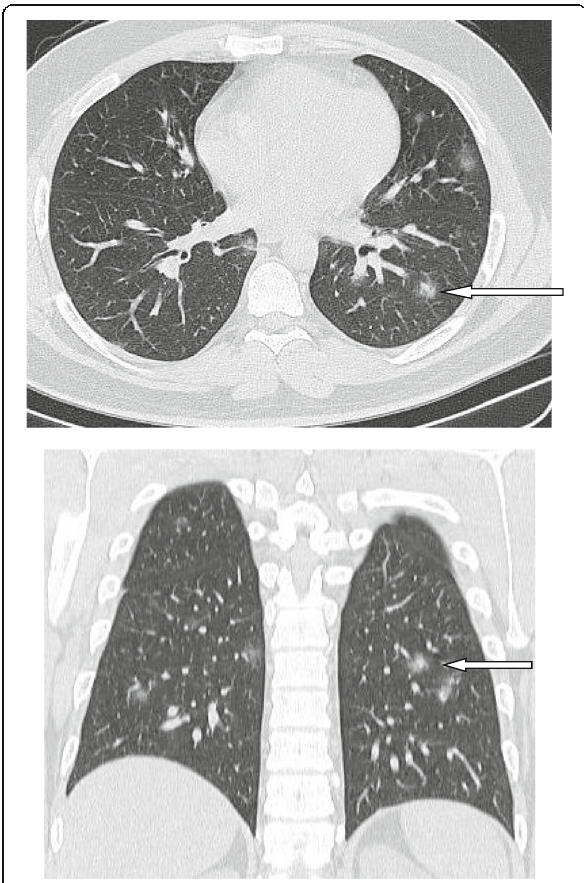
Fig. 15 Patient with COVID-19, with few patches of GGO, with halo sign in few lesions